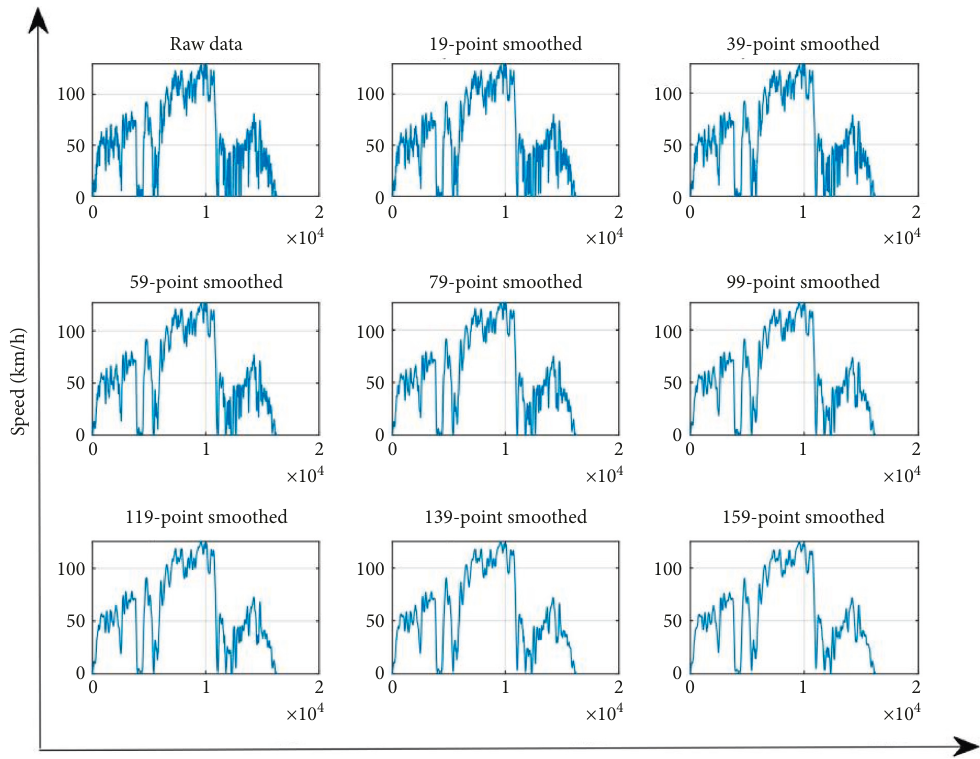
Figure 6: Speed traces with different filters on route A.